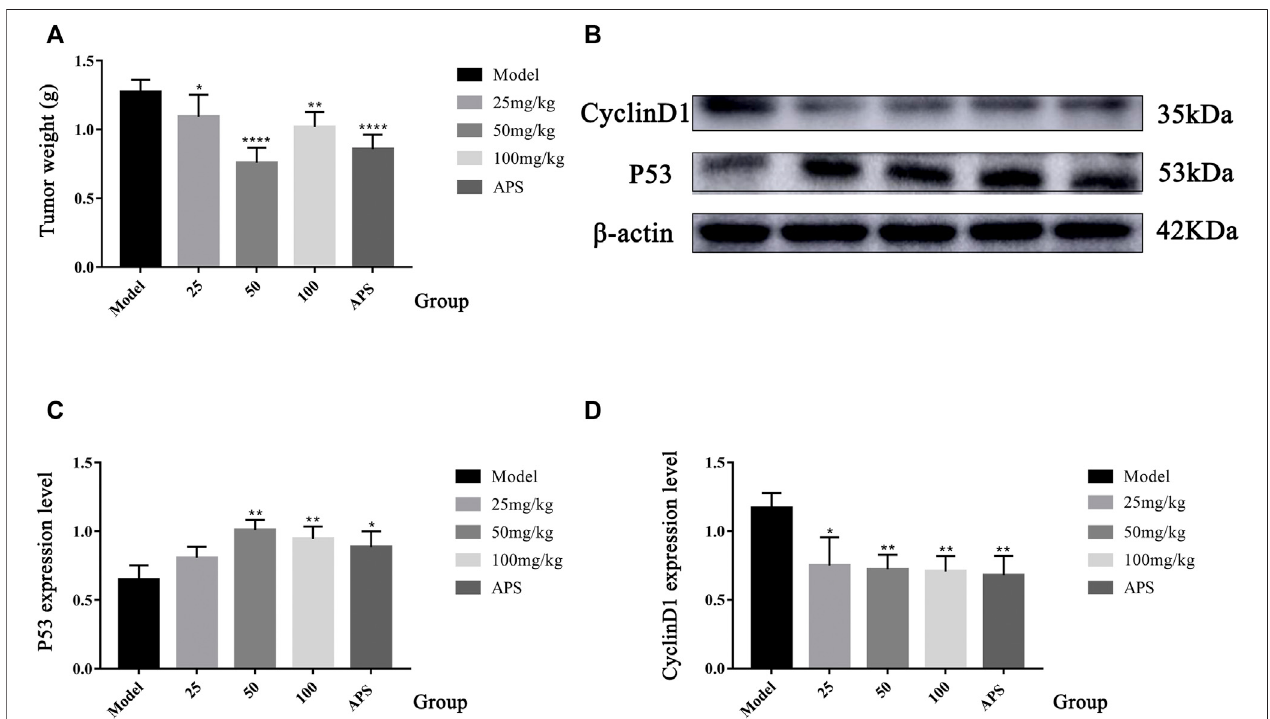
FIGURE 9 | Tumour weight of H22 tumour-bearing mice (A) . Compared to the model group, * p < 0.05, ** p < 0.01, and **** p < 0.0001. The protein expression of P53 and CyclinD1 (B – D) . Contrast to the model group, * p < 0.05, and ** p <